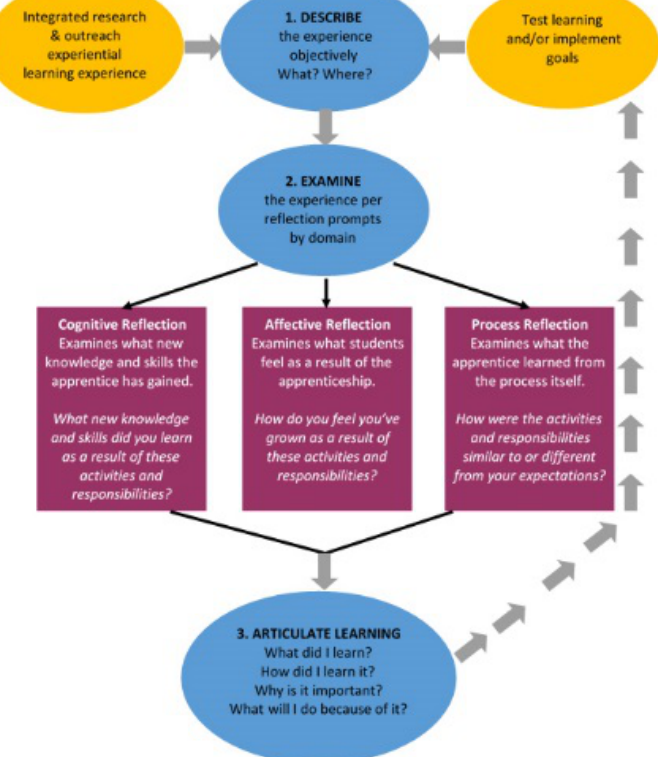
Figure 1. Alignment of the DEAL Model to the Mississippi Extension Apprenticeship